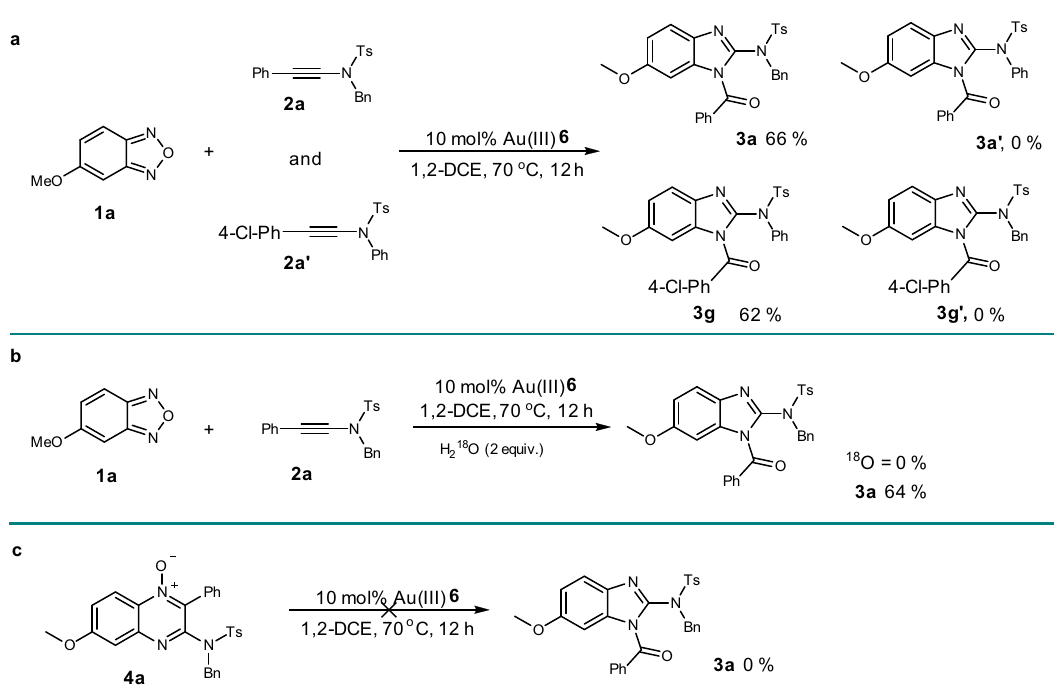
Fig. 6 Mechanistic experiments. a Intermolecular control experiment. b 18 O-labing experiment. c Exclusion of the transformation from 4a to 3a